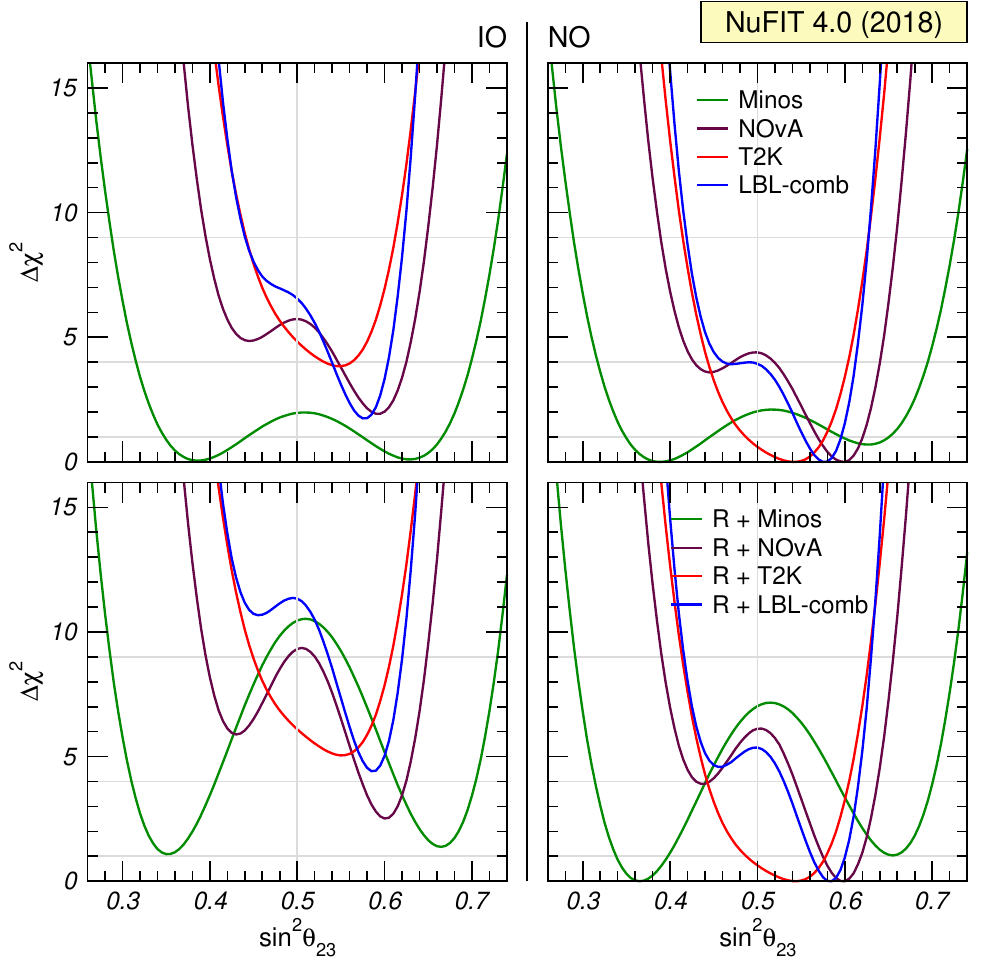
Figure 7 . (cid:18) 23 determination from LBL, reactor and their combination. Left (right) panels are for IO (NO). The upper panels show the 1-dim (cid:1) (cid:31) 2 from LBL experiments after constraining only (cid:18) 13 from reactor experiments. For each experiment (cid:1) (cid:31) 2 is de(cid:12)ned with respect to the global minimum of the two orderings. The lower panels show the corresponding determination when the full information of LBL accelerator and reactor experiments is used in the combination (including the information on (cid:1) m 2 from reactors). In all panels (cid:1) m 2 , sin 2 (cid:18) 12 are (cid:12)xed to the global best (cid:12)t 21 3 ‘